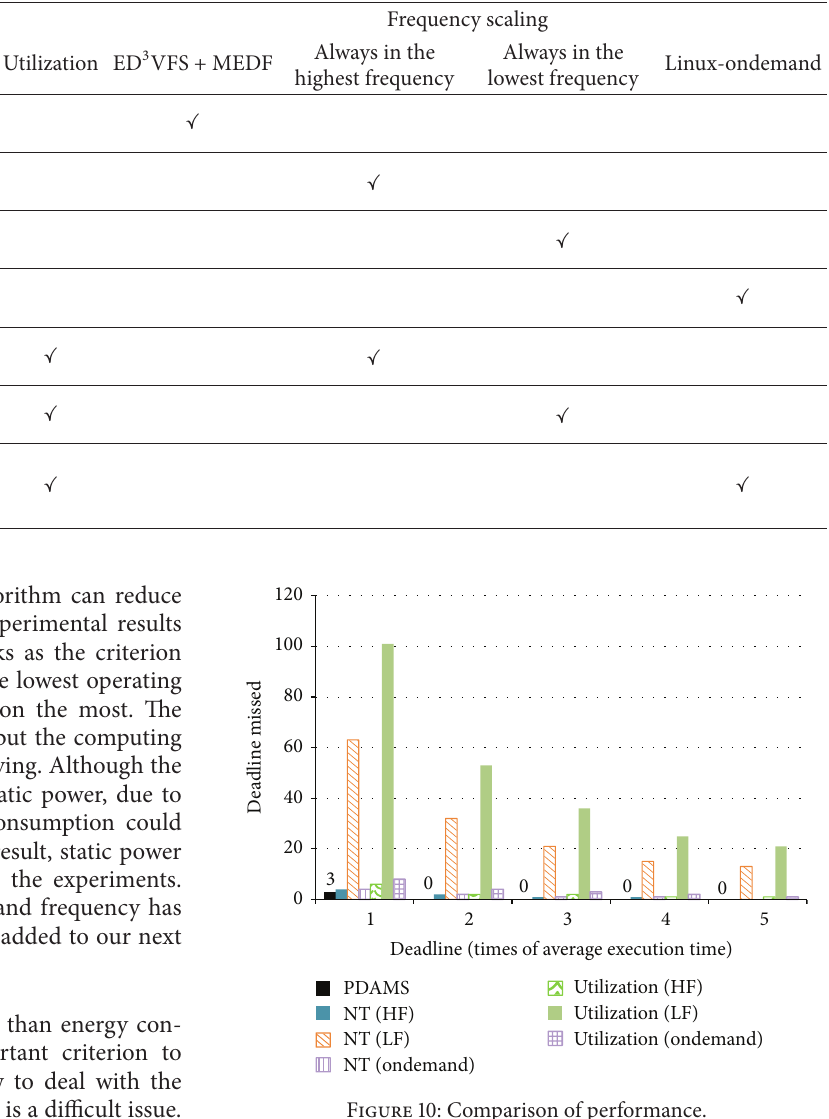
Table 3: Usage of algorithms for experiments.